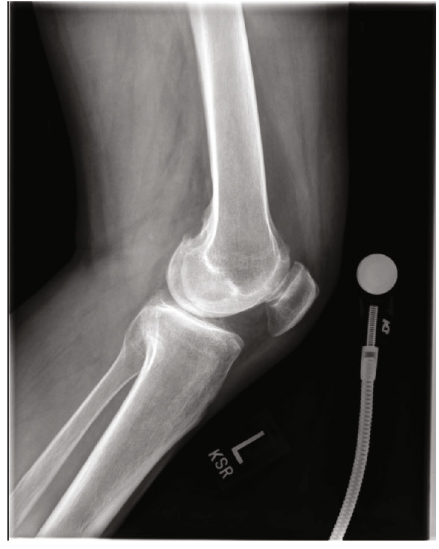
Figure 2: Preop lateral knee